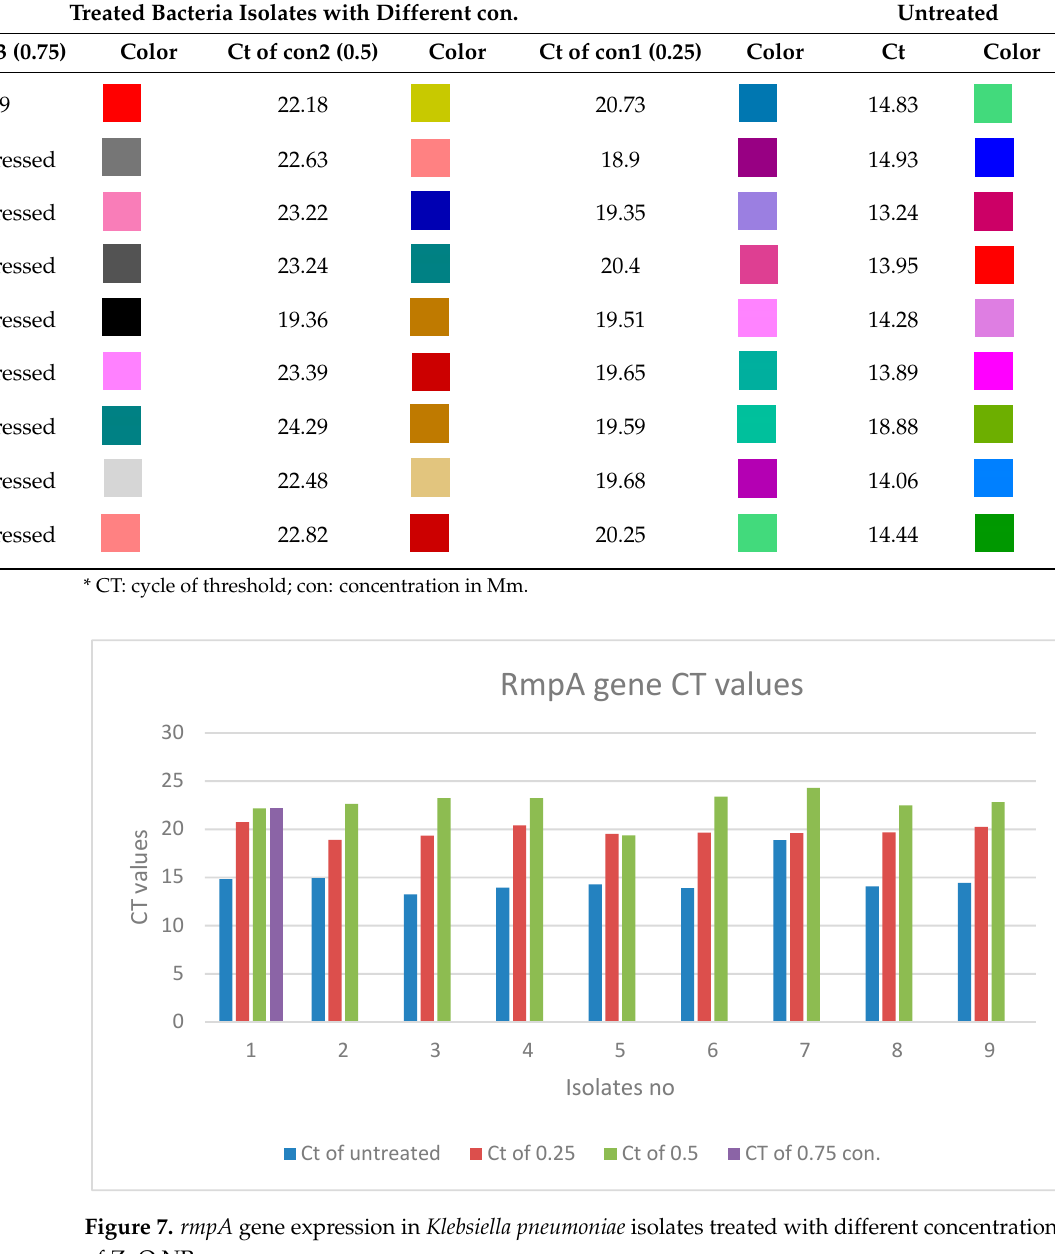
Table 5. rmpA gene expression in Klebsiella pneumoniae isolates treated with different concentrations of ZnO NPs *. Treated Bacteria Isolates with Different con.